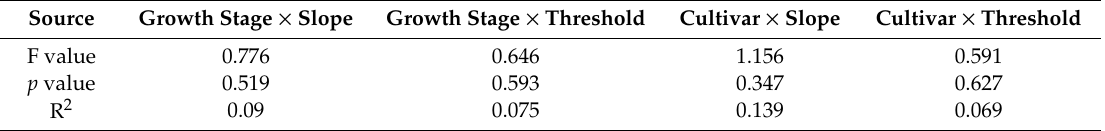
Table 2. The e ff ects of growth stages and cultivars were tested by the analysis of variance tests. Source Growth Stage × Slope Growth Stage × Threshold Cultivar × Slope Cultivar × Threshold F value